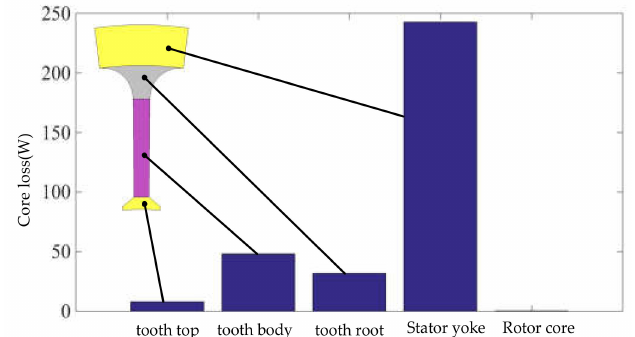
Figure 8. Stator core loss distribution in each region during rated operation.